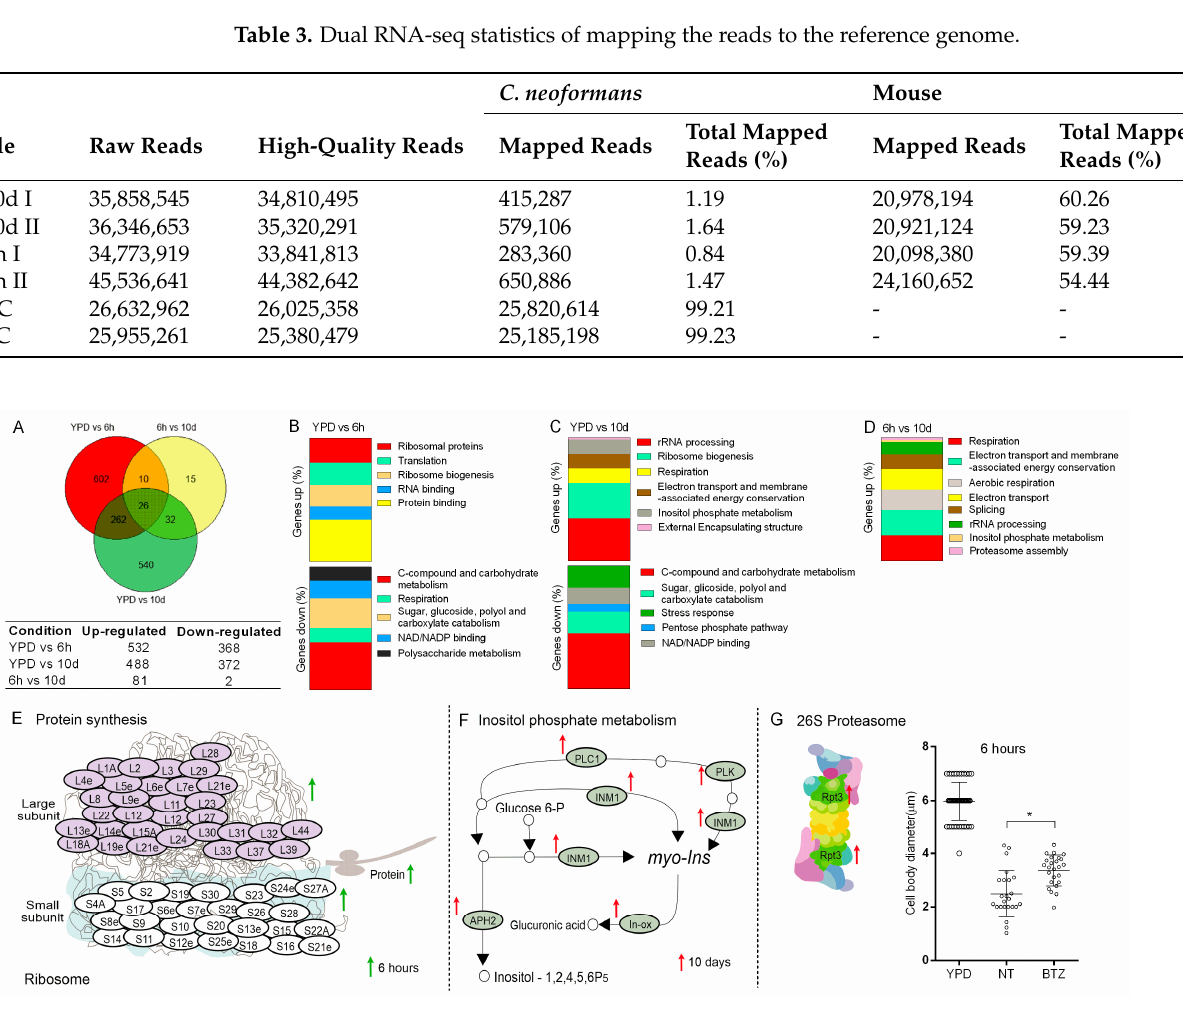
Figure 4. Differentially expressed genes (DEGs) in C. neoformans strain H99 during mice infection. ( A ) Venn diagram showing the number of H99 transcripts modulated comparing 6 h and 10 d of infection and YPD cultured yeasts. ( B – D ) GO biological processes enriched in H99 after 6 h and 10 days of intratracheal infection, for each comparison. ( E ) Upregulated transcripts related to ribosome subunits after 6 h of infection compared to YPD. ( F ) Genes involved in inositol metabolism differentially expressed after 10 days of infection (CNAG_00038, CNAG_00730, CNAG_00869, CNAG_01823,